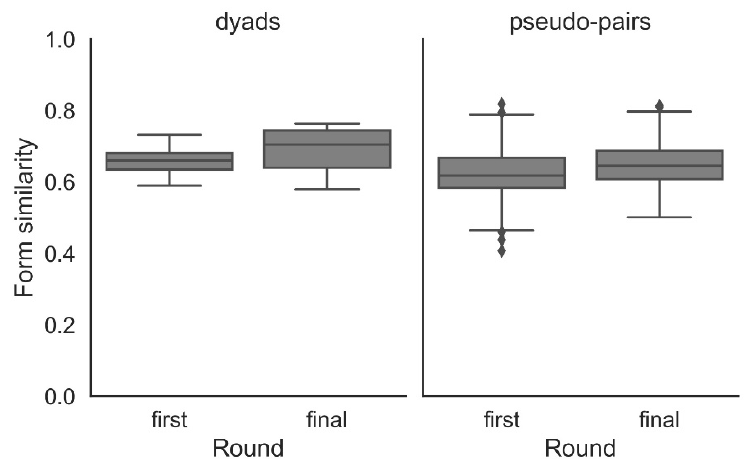
Figure 7. Similarity in form parameters across rounds for real-paired dyads and pseudo-dyads (i.e., who did not interact during the experiment).